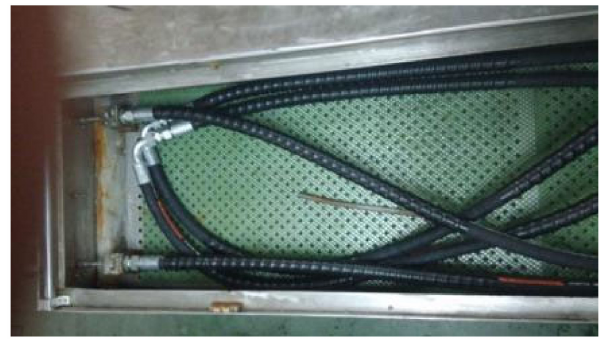
Figure 20. Six hose assembly